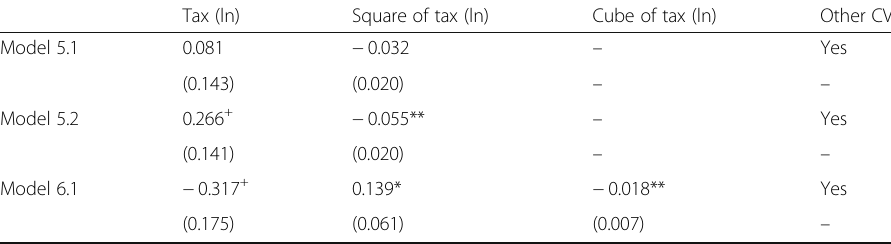
Table 5 Further MNL models predicting strategy selection ( N = 1272)